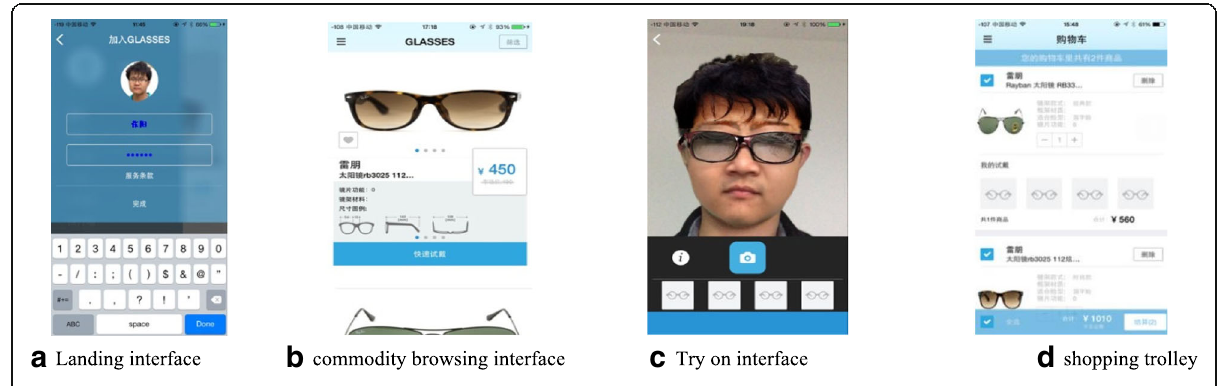
Fig. 24 The part of interface for system